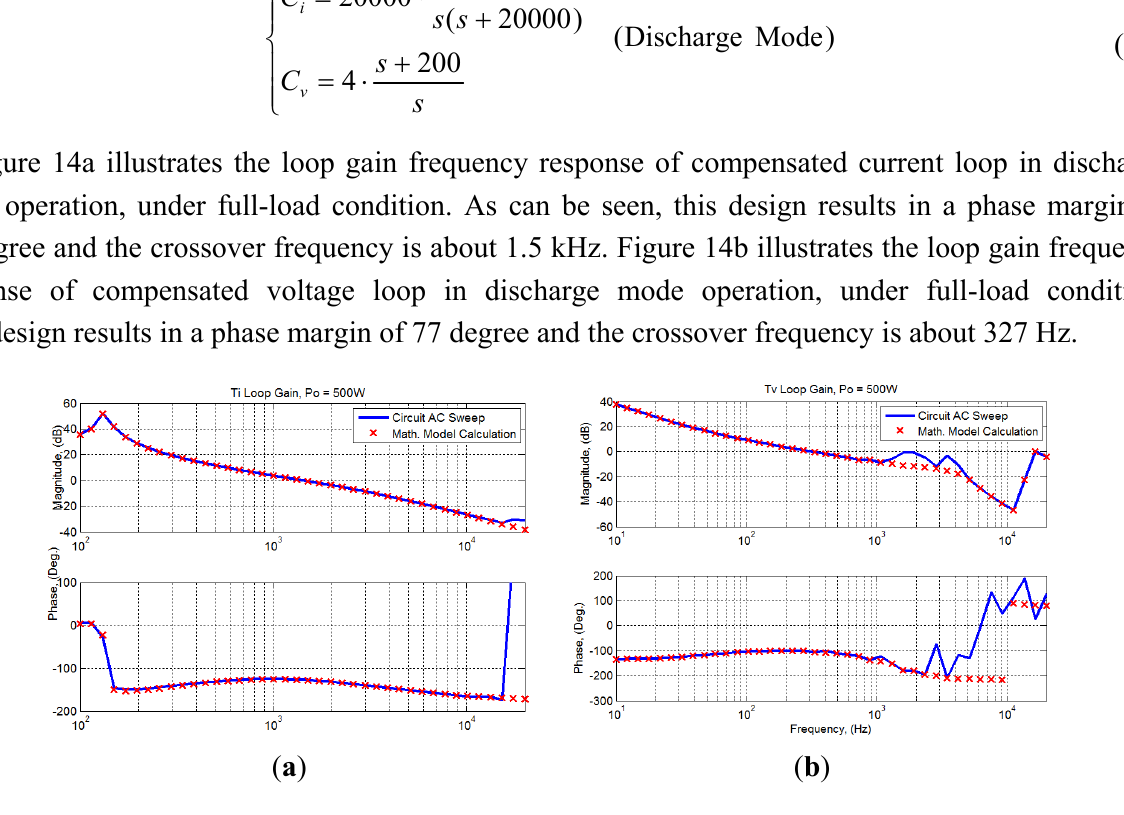
Figure 14. Loop gain frequency responses of compensated in discharge mode operation ( a ) current loop and ( b ) voltage